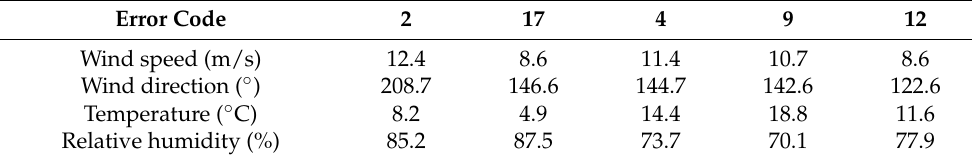
Table 7. Example of average values of the climate variables for each